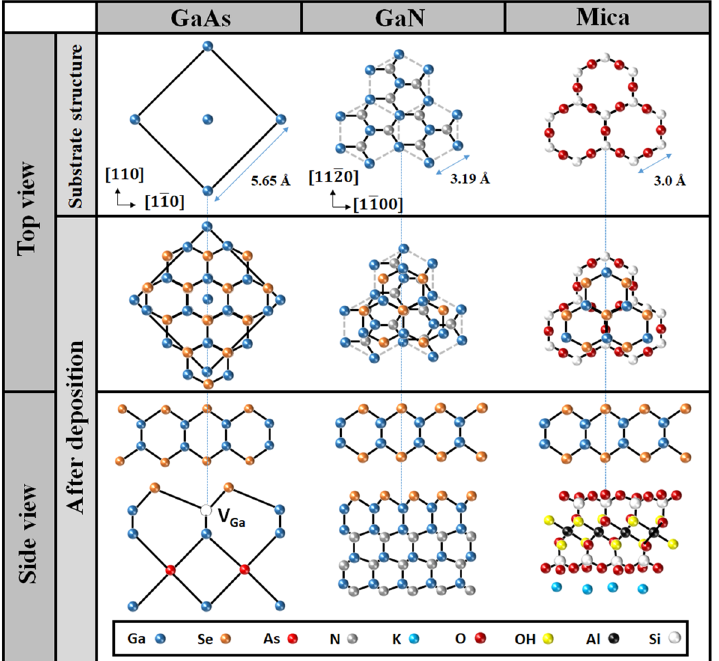
Figure 2. Illustration of perspective atomic-stacking configuration between GaSe layers and substrates.